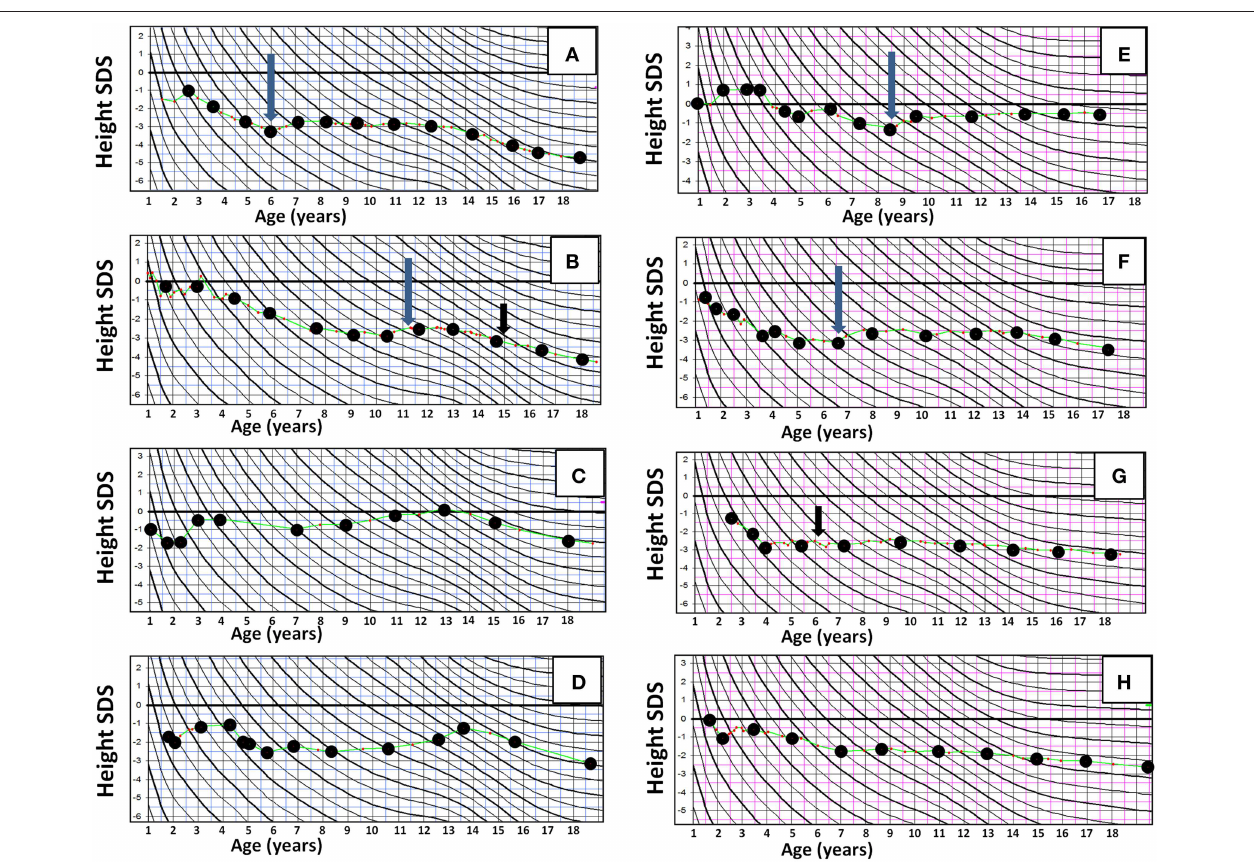
FIGURE 3 | Representative individual growth curves in height in long-term survivors of high-risk neuroblastoma (HR-NBL), shown in height SD scores according to Finnish growth curves, with age in years at X axis and height SDS at Y axis. (A–D) Male survivors of high-risk neuroblastoma: (A,B) TBI treated. Growth failure begins after HR-NBL diagnosis and becomes more pronounced with lacking pubertal growth spurt. (C) No TBI. Normal growth velocity after HR-NBL treatment, but mildly compromised adult height due to early pubertal growth spurt. (D) No TBI. Growth failure after HR-NBL treatment, and early pubertal growth spurt leading to further compromised adult height. (E–H) Female survivors of HR-NBL. (E) TBI treated. Slightly compromised growth velocity after HR-NBL treatment in early childhood, but after that (with GH) normal growth and normal pubertal growth. (F) No TBI. Pronounced growth failure begins after HR-NBL treatment; blunted pubertal growth spurt. (G–H) Both TBI treated. Growth failure begins after HR-NBL treatment and is further augmented with blunted pubertal growth. Long arrow, GH treatment begins; short arrow, thyroxine substitution for hypothyroidism